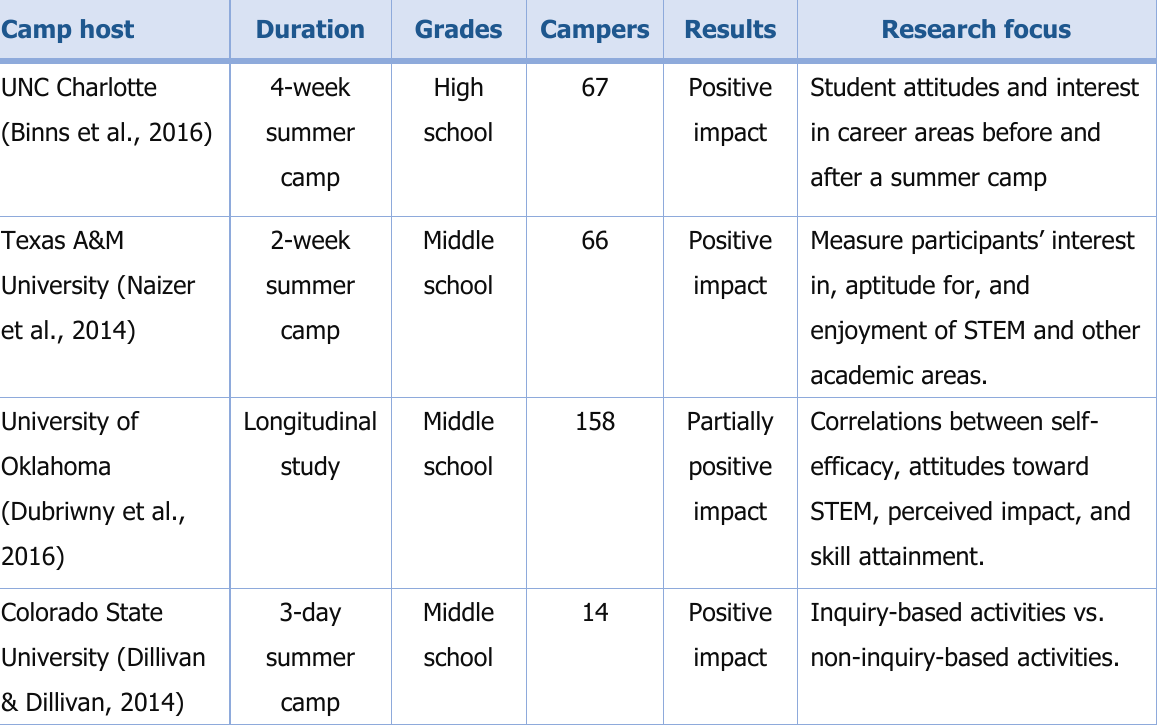
Table 1. Comparison of STEM Camp